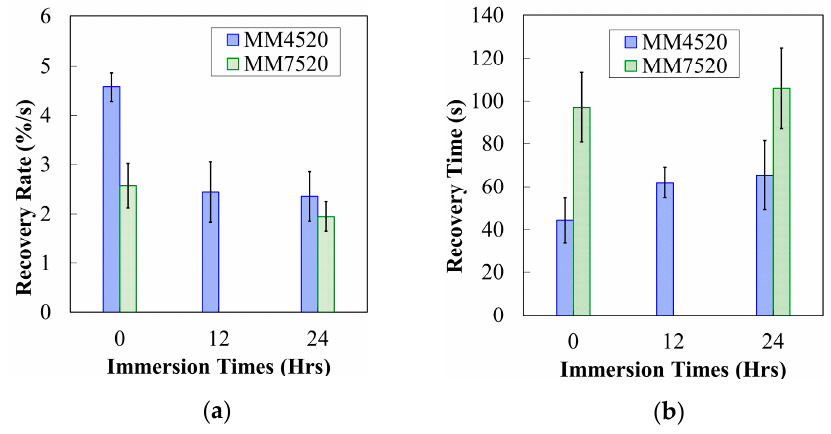
Figure 13. ( a ) Recovery rate for MM4520 and MM7520 with respect to immersion times in water ( b ) Recovery time for MM4520 and MM7520 with respect to immersion times in Recovery time for MM4520 and MM7520 with respect to immersion times in water.